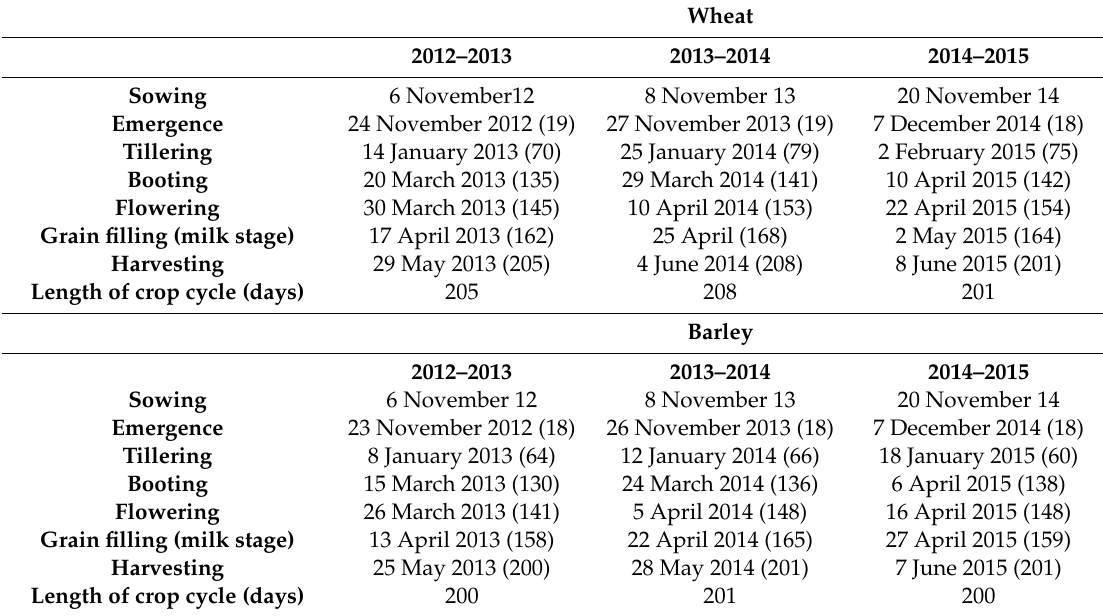
Table 2. Experimental details and dates of the main phenological stages for durum wheat and barley during the three growing seasons. In brackets the days after sowing (DAS) are